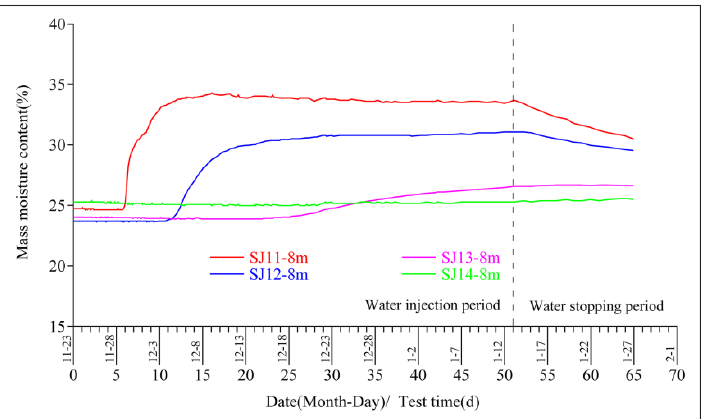
Figure 8. Moisture meter monitoring curves.